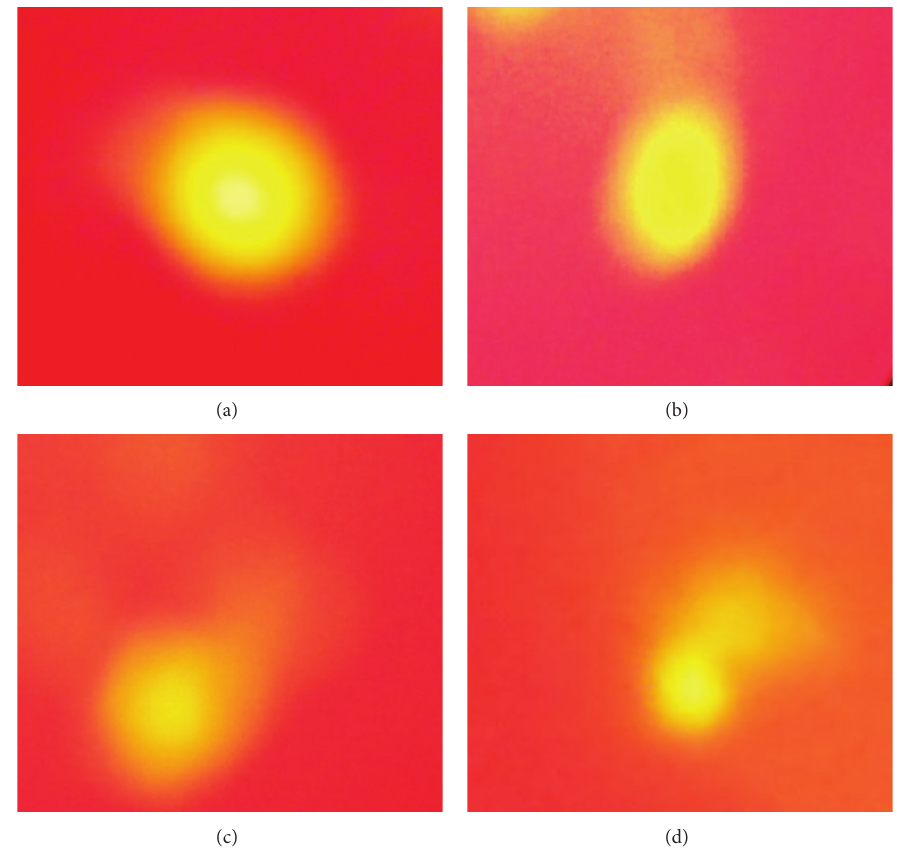
Figure 7: Fluorescence microscope images (comets) of the propidium iodide stained DNA of Artemia nauplii cells exposed to LC 50 concentration of 10nM AgNPs (c), minimum concentration of 2nM AgNPs (b), and maximum concentration of 12nM AgNPs (d) as compared with the control (a) (40x